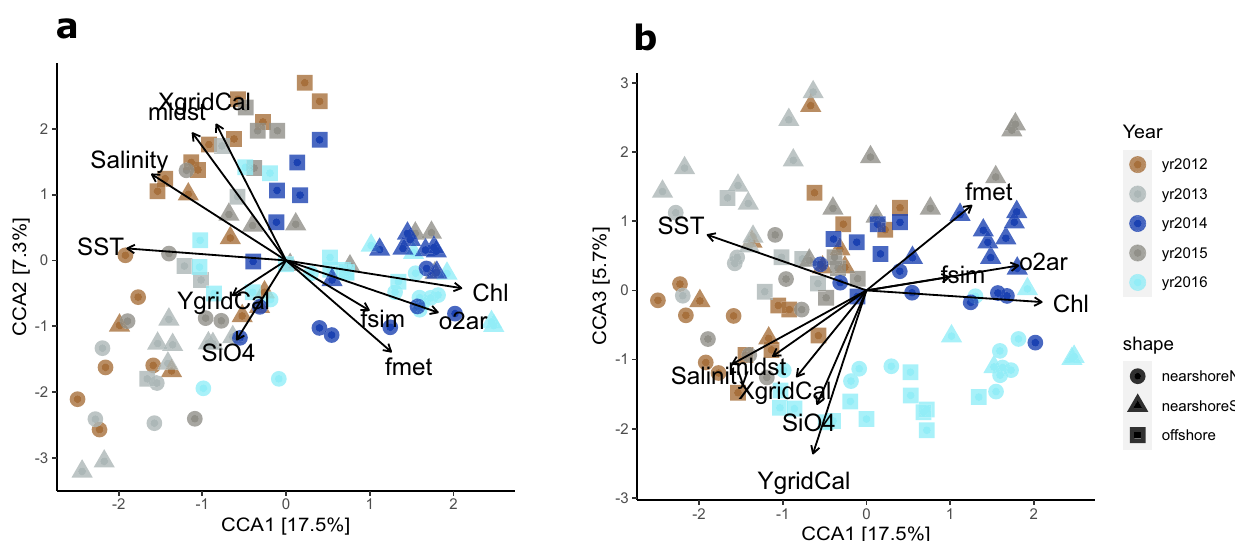
Fig. 3 Canonical correspondence analysis (CCA) biplots. Each point represents the eukaryotic plankton community composition from a surface ocean sample with year indicated by color and station type (i.e., offshore, nearshore north, or nearshore south) indicated by shape. CCA1 and 2 are depicted ( a ) as well as CCA1 and 3 ( b ). Vectors indicate stepwise selected environmental constrains, both biotic and abiotic, with factor names marked at the end. Acronyms for selected environmental factors: SST – sea surface temperature, SiO4 – silicate concentration, mldst – mixed layer depth de fi ned by potential density, XgridCal – X grid or grid station calculated from GPS, YgridCal – Y grid or grid line calculated from GPS, f sim – fraction of sea-ice melt estimated from δ 18 O, f met – fraction of meteoric water estimated from δ 18 O, Chl – chlorophyll concentration, o2ar – biological oxygen supersaturation. Source data are provided as a Source Data fi le.